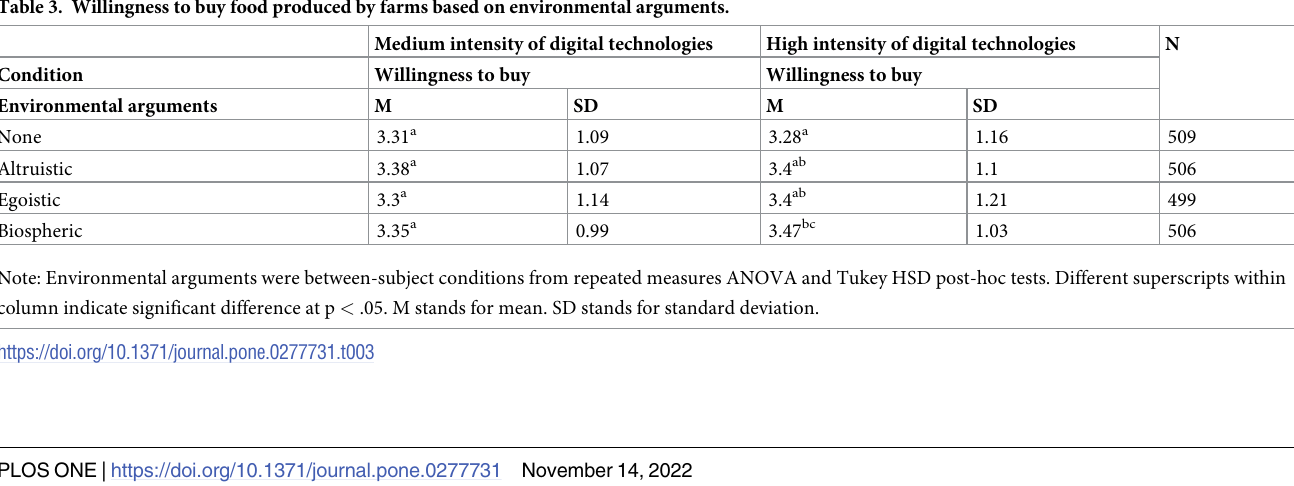
low (M = 3.46, SE = 1.05), medium (M = 3.34, SE = 1.08), and high (M = 3.39, SE = 1.13) inten- sities of DA were incorporated. Thus, the test supported H1b and H1c, suggesting that WTB of food produced by large professional farms and conventional farms does not reach the level of small family farms (H1b) or organic farms (H1c) when DA was incorporated. WTB of food produced by large professional farms/conventional farms was significantly higher when a low intensity of DA was incorporated into the illustrated farming system com- pared with a medium intensity of DA. However, WTB was not significantly different between large professional farms/conventional farms incorporating either low intensity or high inten- sity of DA. Therefore, there is no support for H1a: WTB of food produced by a farming system actually decreases from a low to medium intensity of DA, while there might be no difference between medium and high intensities of DA. Between-subjects one-way ANOVAs were used to compare the effects of environmental arguments (no arguments, altruistic arguments, egoistic arguments, and biospheric argu- ments) added to mission statements of large professional farms/conventional farms with medium and high intensities of DA on the WTB food produced by these farming systems (see Table 3). The ANOVA testing WTB food produced by large professional farms/conventional